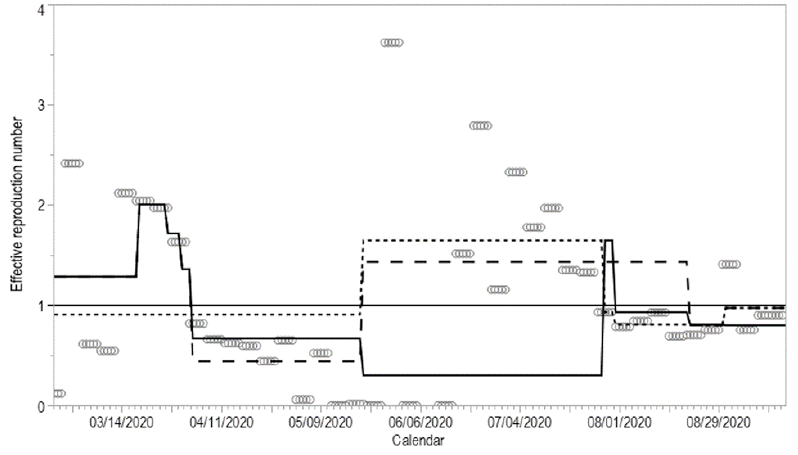
Figure 4. Comparison of event-based models of the effective reproduction number. Unfilled circles represent estimates based on the 5-day piecewise constant model. The solid line shows the full event-based model accounting for all changes in R ( t ) on days 31, 39, 43, 46, 94, 162, 165, 186 and 196. The dotted line represents an alternative model ignoring any intervention dates (i.e., days 31, 39, 43 and 46) during the first wave. The dashed line represents another alternative model ignoring intervention dates (days 162 and 165) during the second wave.